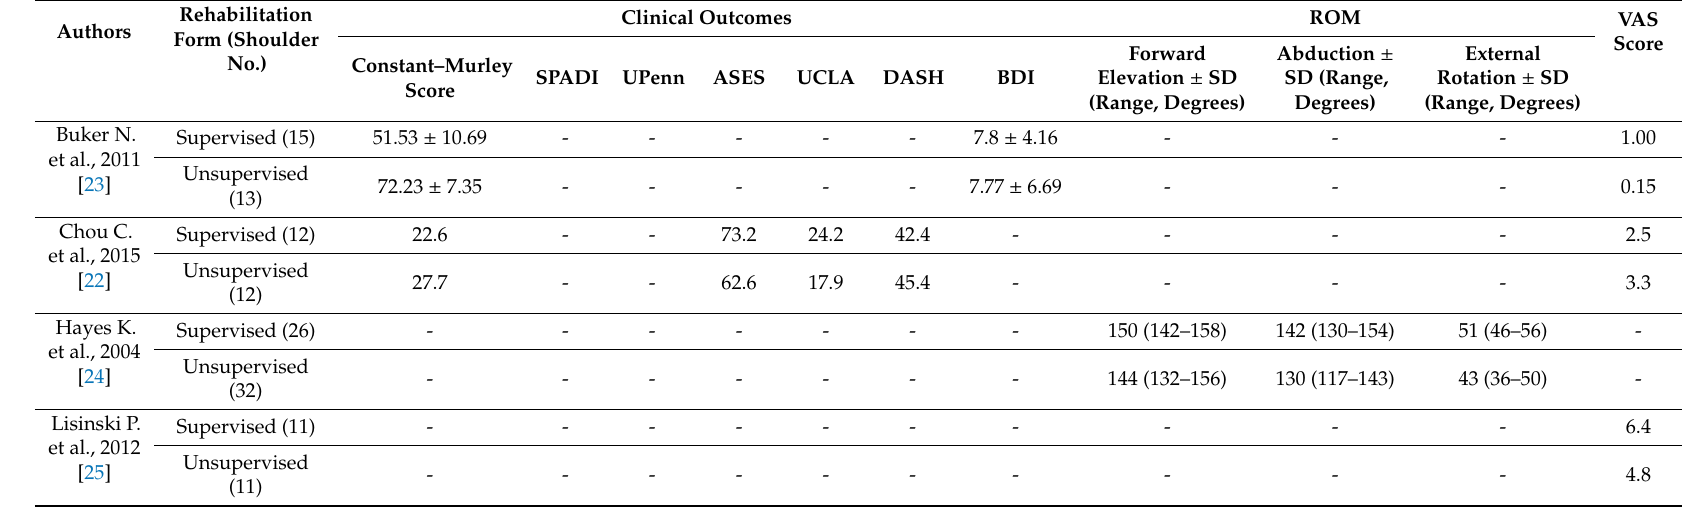
Table 2. Clinical outcomes, range of motion (ROM), and visual-analog-scale (VAS) score. Note: SPADI, Shoulder Pain and Disability Index; UPenn, University of Pennsylvania; ASES, American Shoulder and Elbow Surgeons; UCLA, University of California at Los Angeles; DASH, Disabilities of the Arm, Shoulder, and Hand; BDI, Beck depression